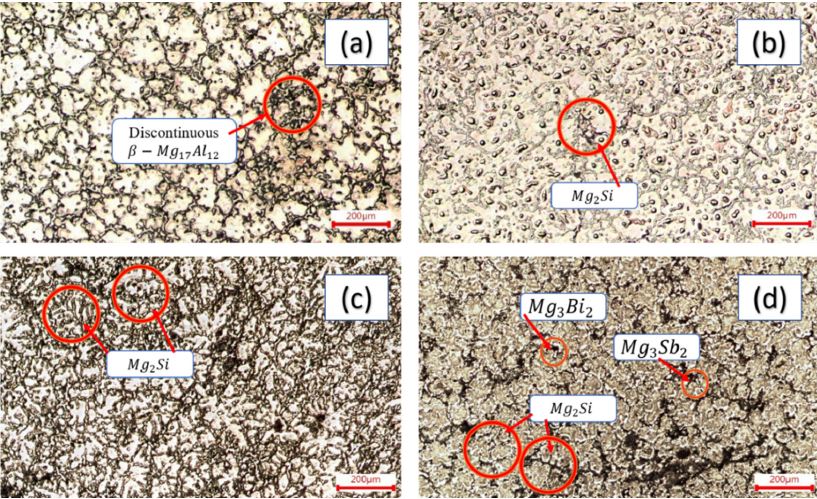
Figure 8. Optical micrographs of ( a ) pure AZ91 matrix, ( b ) AZ91 + 0.5 wt.% SiCp, ( c ) AZ91 + 1 wt.% SiCp and ( d ) AZ91 + 0.5 wt.% SiCp + 1 wt.% Bi + 0.4 wt.% Sb.